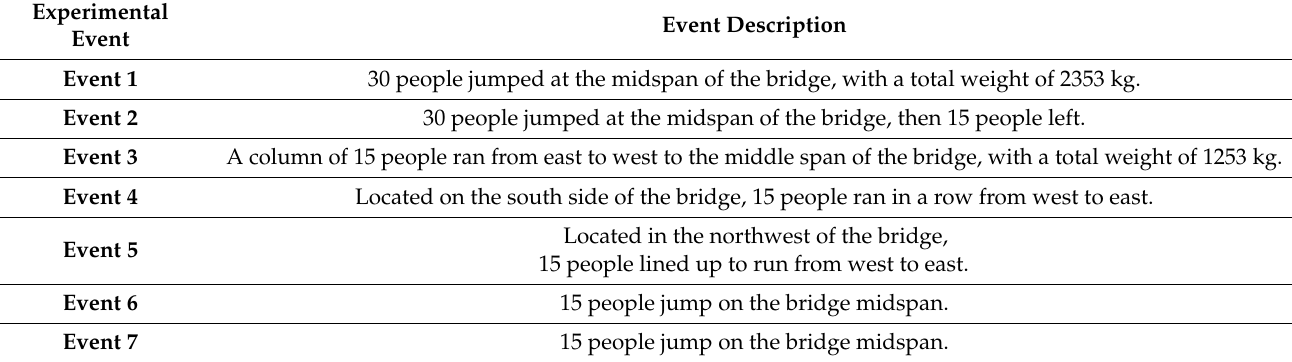
Table 2. Incentive bridge deformation